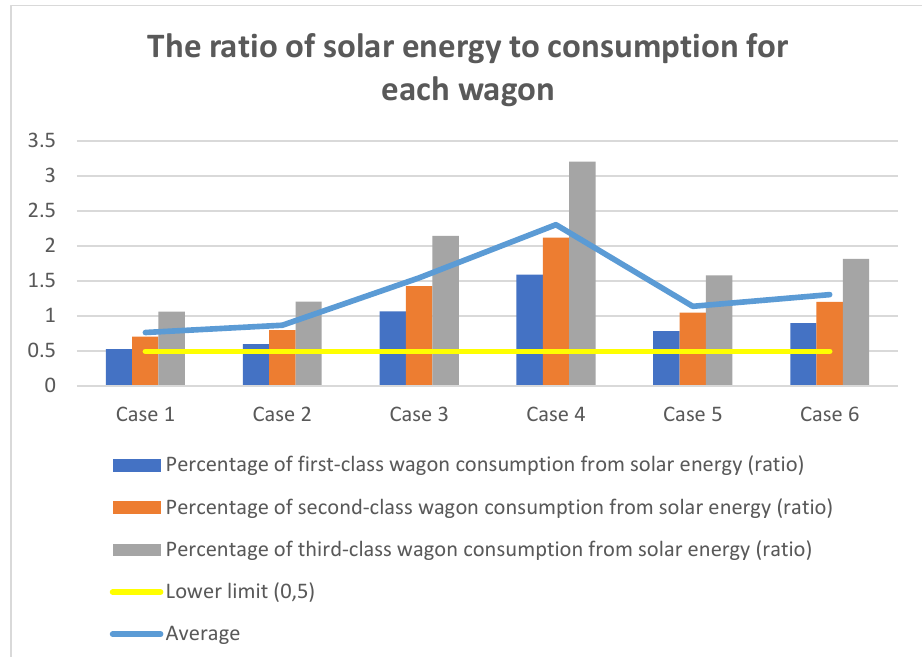
Figure 10. The ratio of solar energy to each wagon’s consumption.